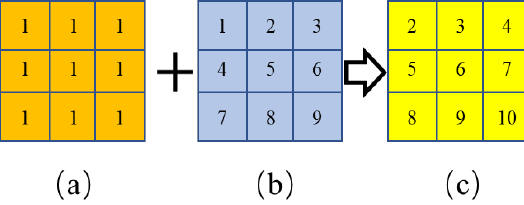
Figure 16. Raster calculation process. According to the corresponding position, the values of the two grids are added to obtain the simulated DEM.2.5. Sea-level Simulation.